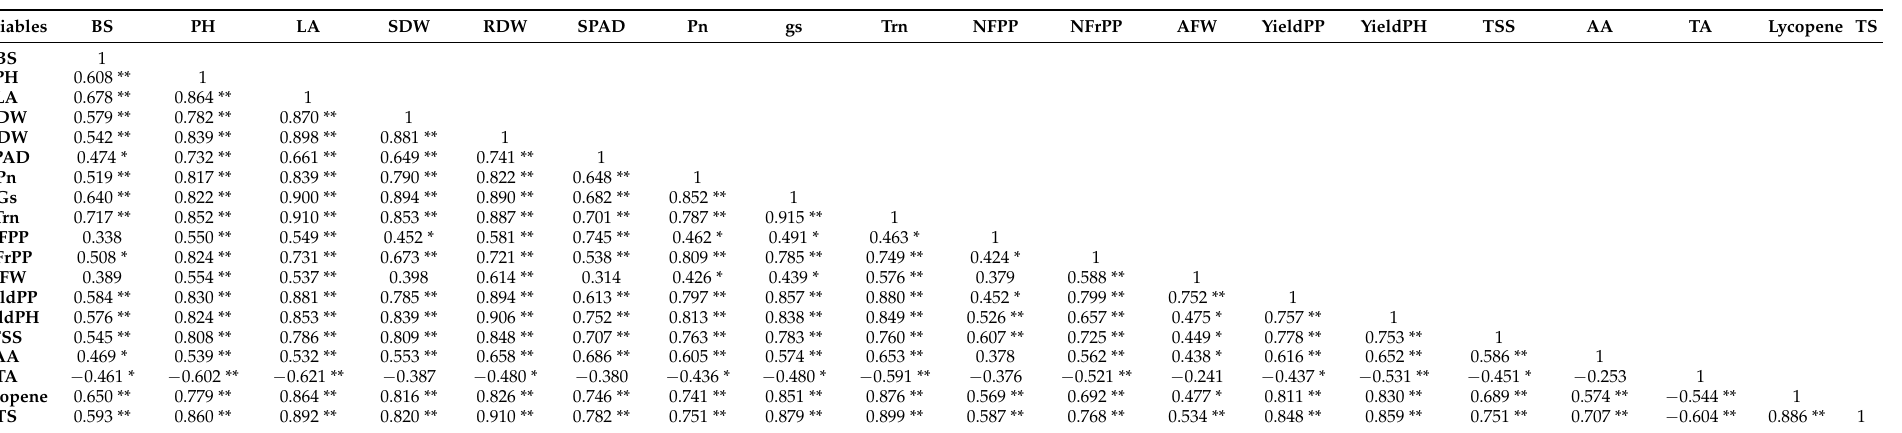
Table 2. Correlation coefficient (Pearson) between biostimulant and assessed variables of